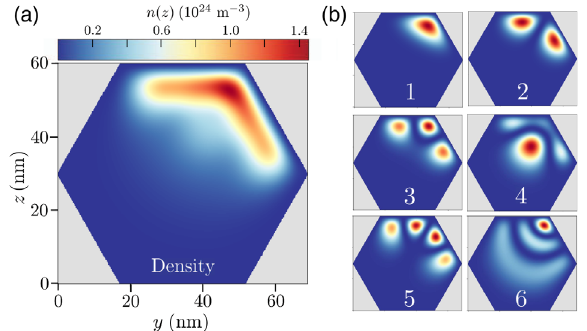
FIG. 3. (a) Electronic density in the cross-sectional cut of the 0 obtained by the Thomas-Fermi approxima- nanowire for V g ¼ tion. (b) Square modulus of eigenstates of the wire in the normal state at B ¼ 0 with energies − 0 . 096 , − 0 . 068 , − 0 . 052 , − 0 . 023 , − 0 . 021 , and − 0 . 006 eV for panels 1 – 6, respectively.